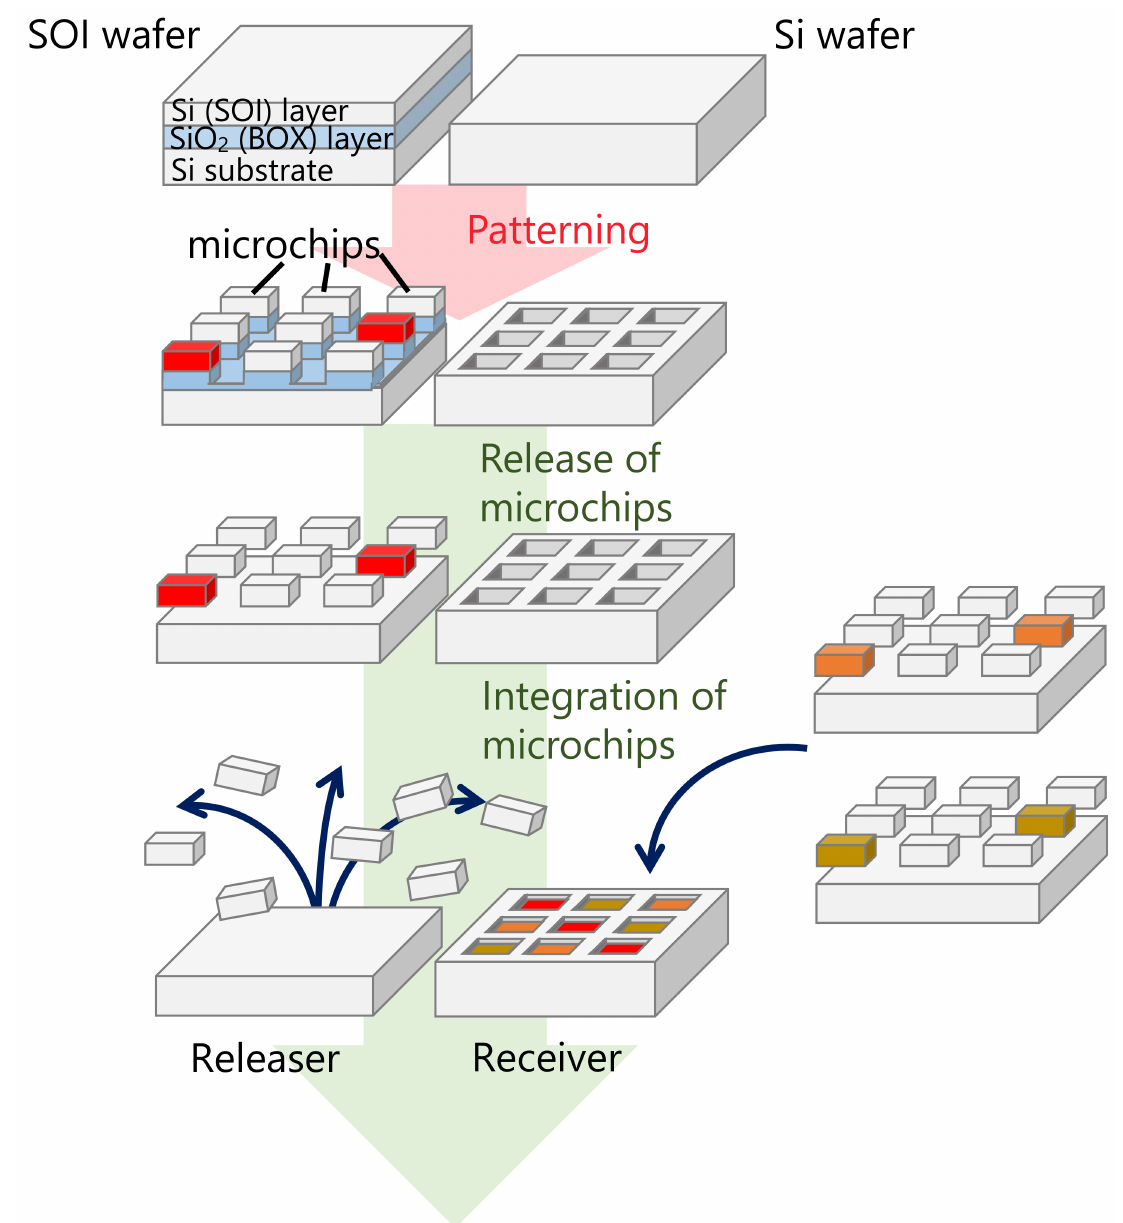
Figure 1. Schematic illustration of a prospective process flow of Si fluidic self-assembly. In practical applications, various- functional microchips from multiple kinds of wafers can be integrated into a single host chip. Different colors of the chips indicate different types of functions of the chips to be